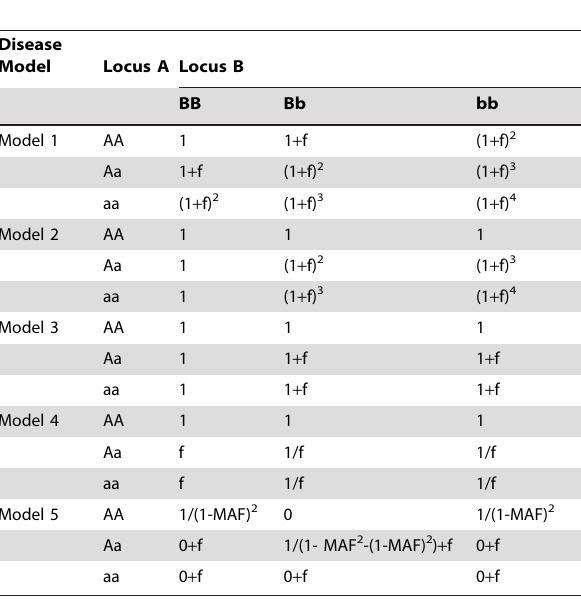
Table 1. Relative risk for combinatory genotypes of disease